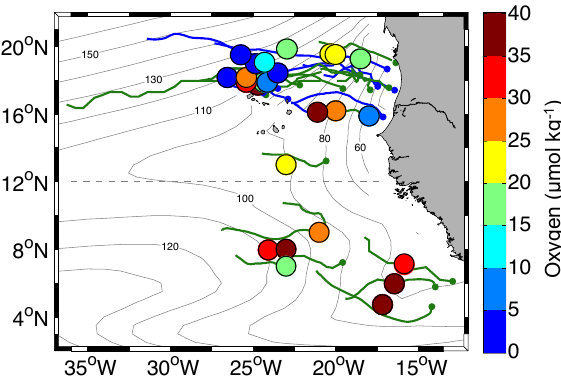
Figure 4. Minimum oxygen concentration (contour lines, µmolkg − 1 ) in the ETNA between the surface and 200m depth as obtained from the MIMOC climatology (Schmidtko et al., 2013). Superimposed colored dots are all low-oxygen measurements (be- low 40µmolkg − 1 in the upper 200m) which could be associated with eddy-like structures. The size of the dots represents a typical size of the mesoscale eddies. The associated trajectories of the ed- dies are shown in green for ACMEs and in blue for cyclones. The oxygen concentrations are from the combined dataset of shipboard, mooring, glider and Argo float